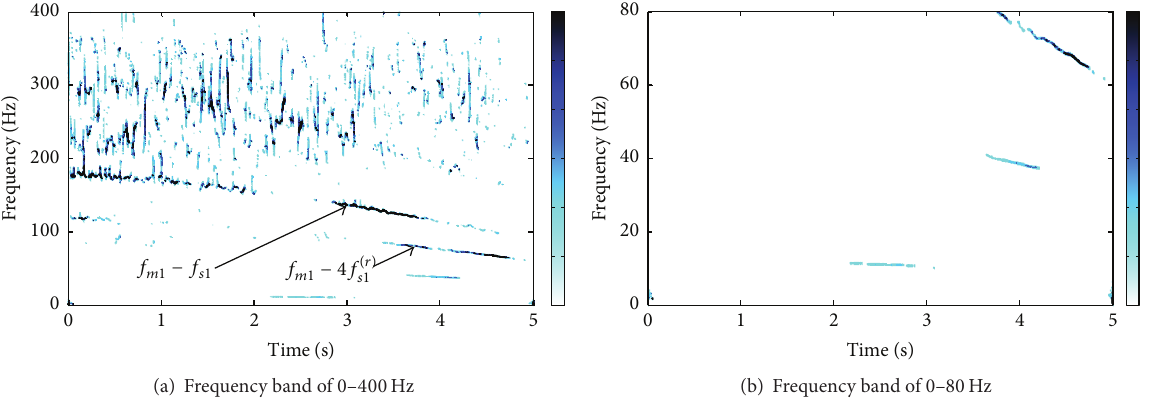
Figure 6: Reassigned scalogram of baseline signal.